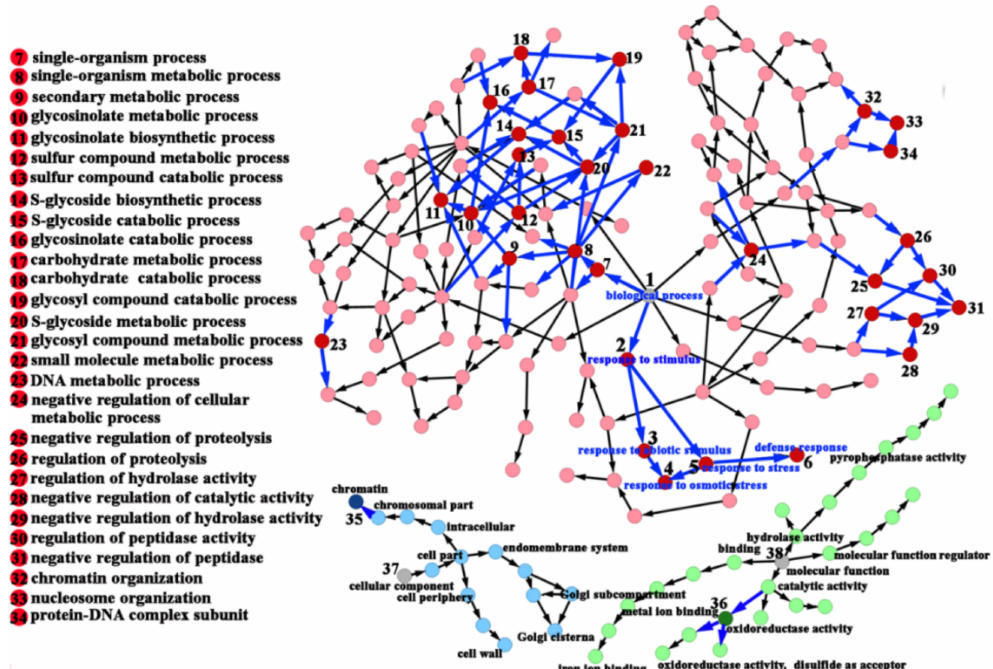
Figure 5. Regulatory network relationships of GO terms of the differentially expressed genes between 35S:: bolTLP1 broccoli and the vector control plants. Each node represents a GO term. GO terms in biological process, cellular component and molecular function were distinguished by red, blue and green color, respectively. The significantly enriched GO terms (corrected p -value < 0.01) are further marked by dark color, and their inclusion relations are highlighted by thick and blue arrows. The inclusion relations of other GO terms are marked by black arrows. Only those significantly enriched GO terms are serially numbered and their functional annotations were showed. The functional annotations of other enriched GO terms can be found in Table